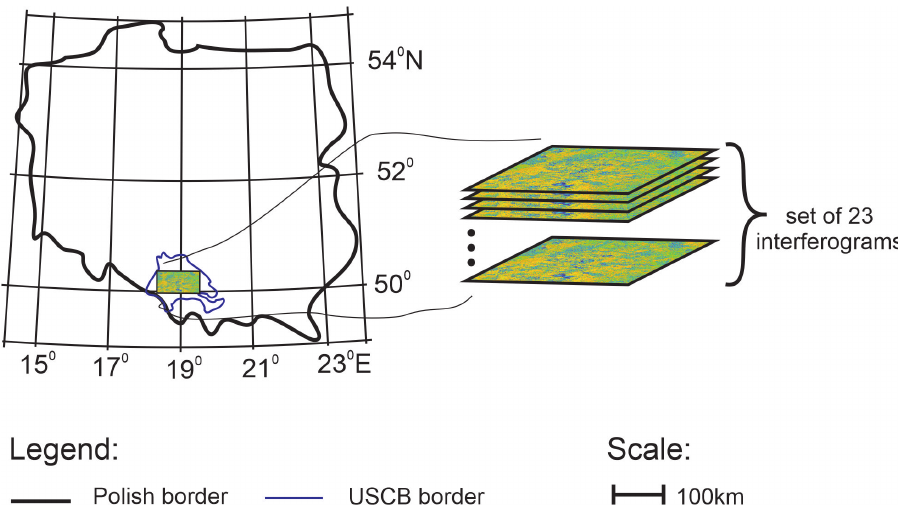
Figure 3. A set 23 differential interferograms generated for recordings performed from September 2017 to January 2018. It was calculated from radar images of the Upper Silesia Coal Basin area,